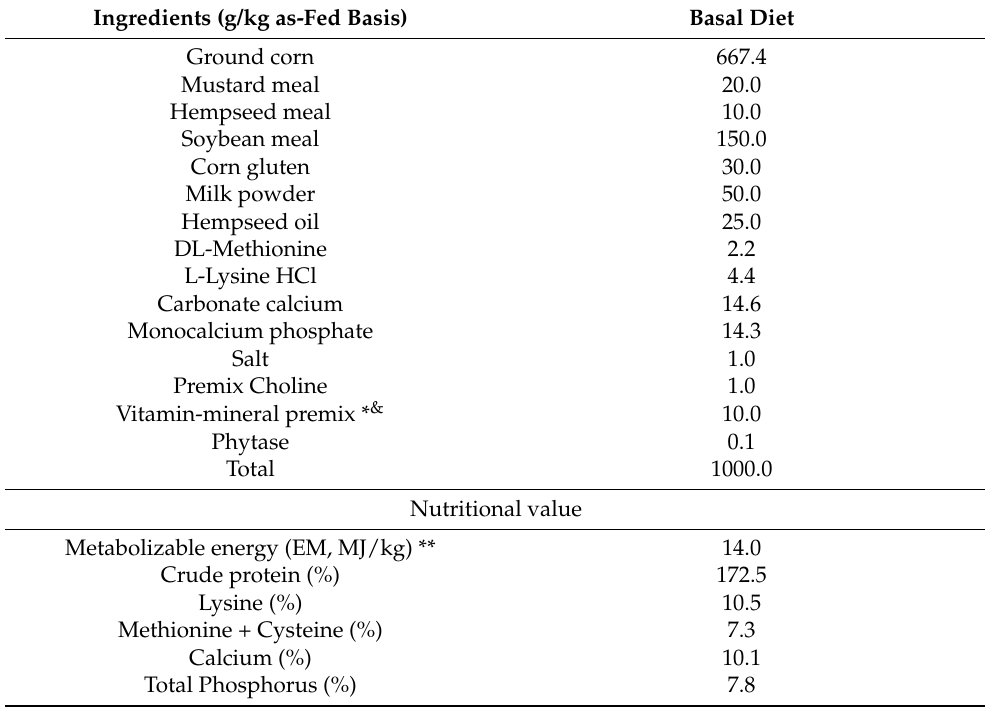
Table 1. Ingredients and nutritional value of the basal